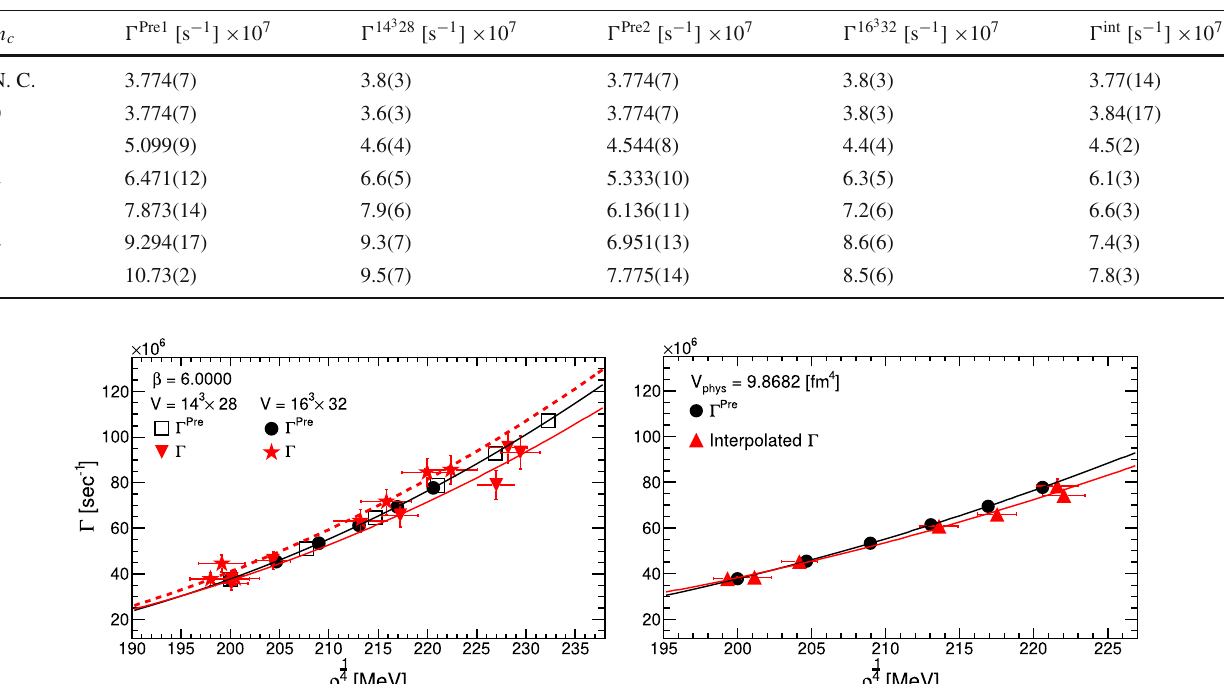
Table 25 Comparisons of the computed results of the decay width (cid:15) 14 3 28 , (cid:15) 16 3 32 , and (cid:15) int with the predictions (cid:15) Pre1 and (cid:15) Pre2 . The out- comes of (cid:15) 14 3 28 , (cid:15) 16 3 32 , and (cid:15) int calculated using the lattice V =